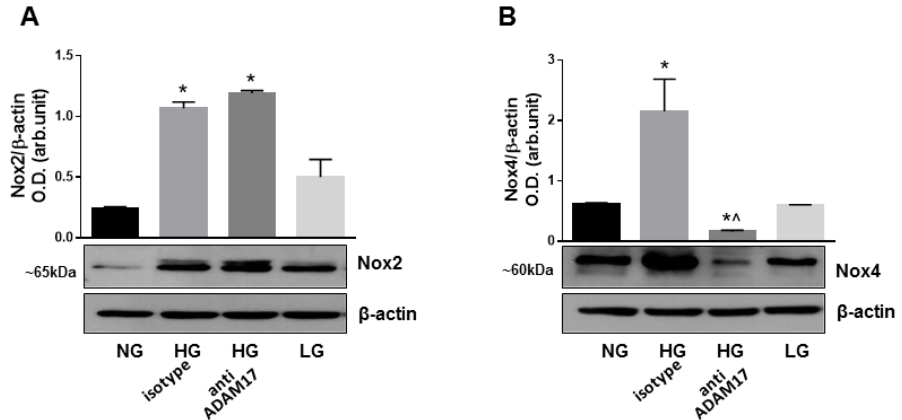
Figure 8. E ff ects of ADAM17 blocking on expression of Nox2 and Nox4 in high glucose-stimulated HREC. Representative blots and densitometry analysis of Nox2 and Nox4 expression in HREC treated with HG in the presence of ADAM17 blocking antibody or control isotype antibody. Data presented as mean ± SE. * p < 0.05 NG vs. HG. ˆ p < 0.05 HG + isotype vs. HG + anti-ADAM17 antibody. n = 4.